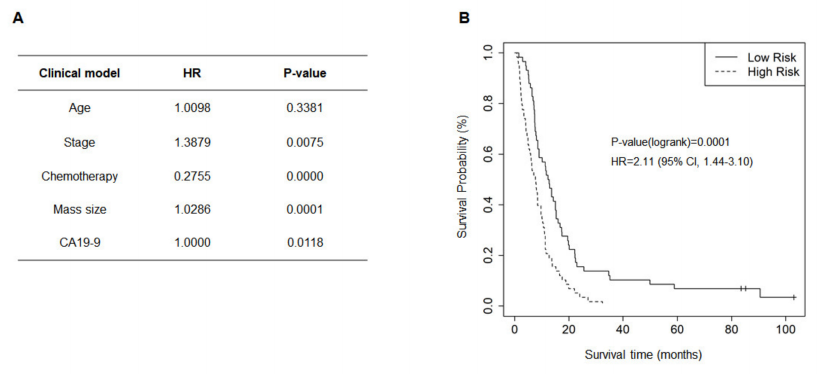
Figure 3. Clinical model. A clinical model considering various clinical parameters were developed to predict the survival of patients with pancreatic ductal adenocarcinoma (PDAC). ( A ) Selected clinical factors to establish the clinical model. ( B ) Kaplan–Meier plot for the high-risk group and the low-risk group of PDAC patients predicted by the clinical model ( p = 0.0001).